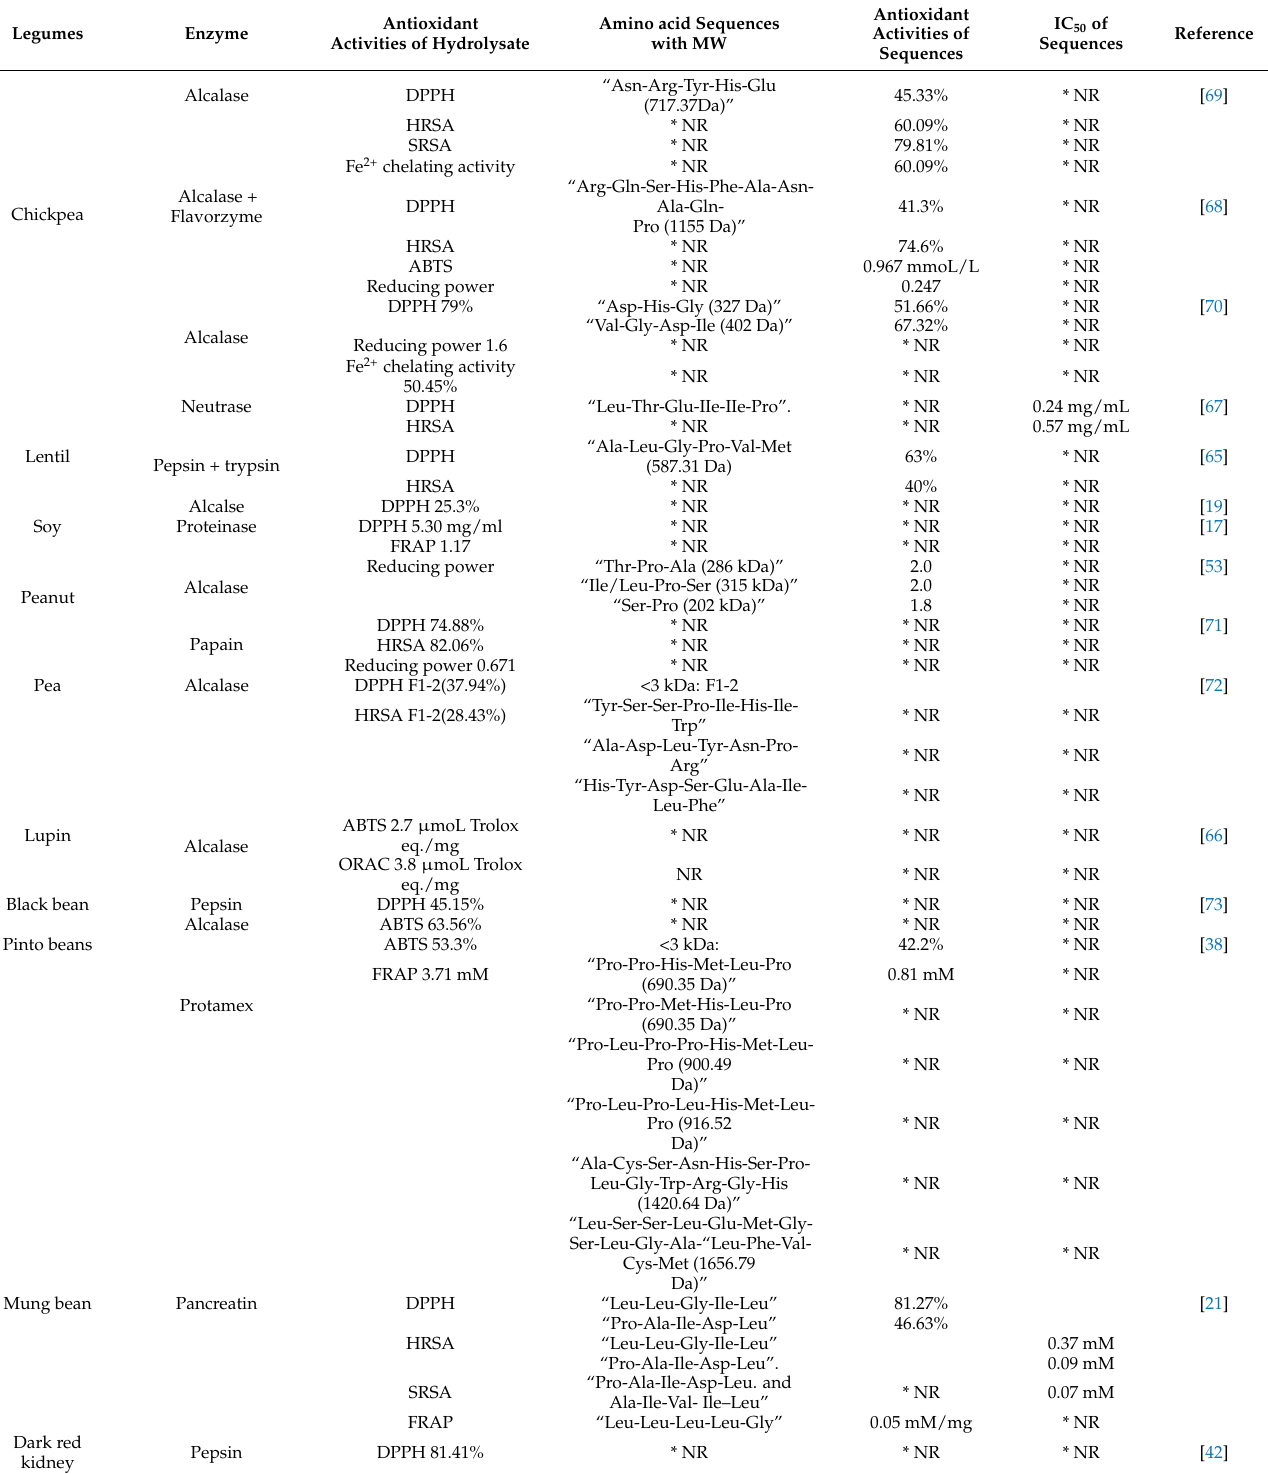
Table 1. In vitro antioxidant activities of legume protein hydrolysates and